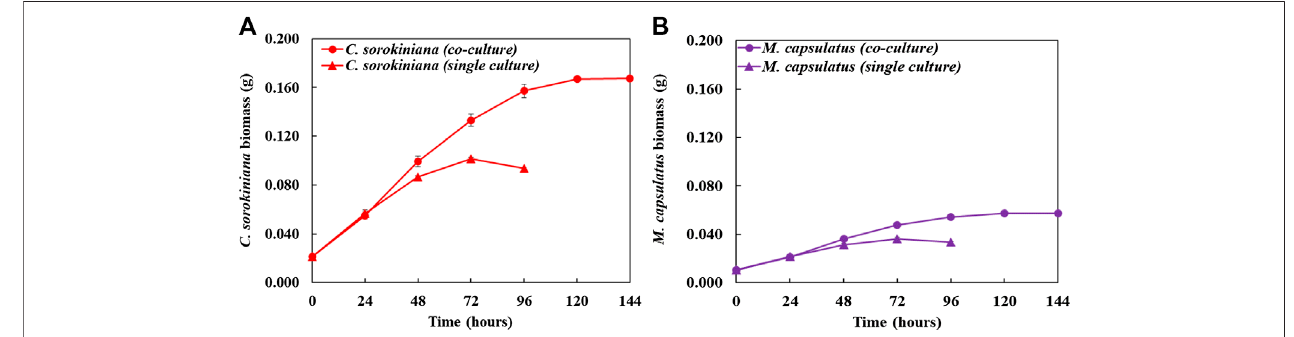
FIGURE8| Time-coursepro fi leofbiomasscomparingtheindividualspeciesincoculturecomparedwithsequential singleculture: (A) Chlorellasorokiniana and (B) Methylococcus capsulatus .